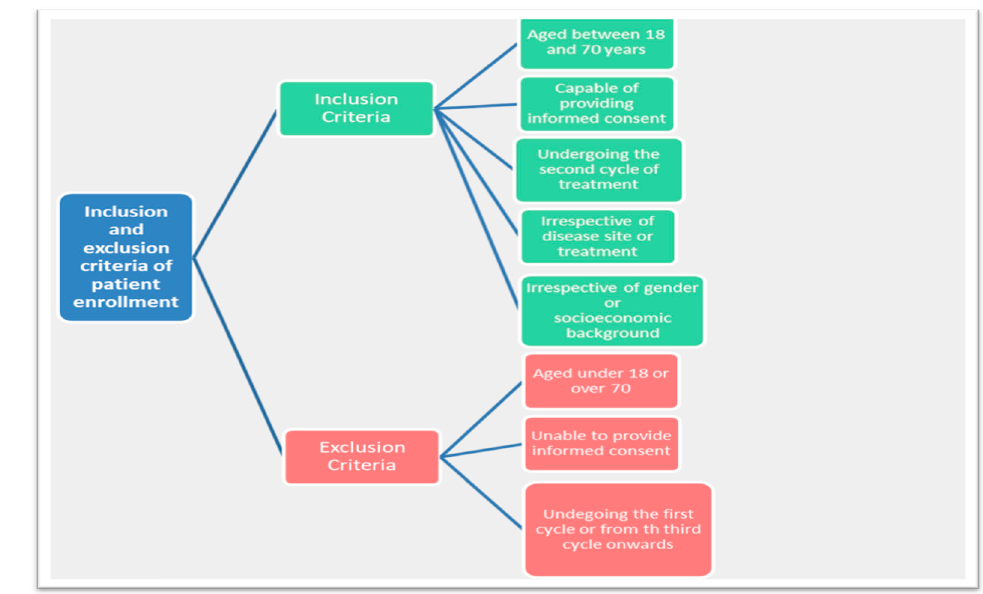
Figure 1. Criteria of inclusion and